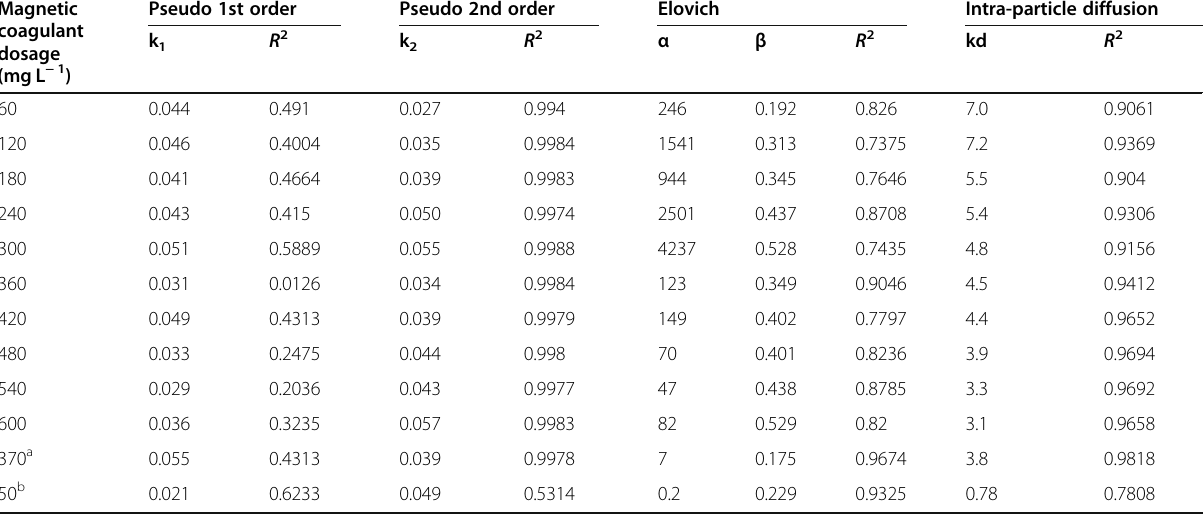
Table 1 Kinetics parameter of Congo red removal Magnetic coagulant dosage (mg L − 1